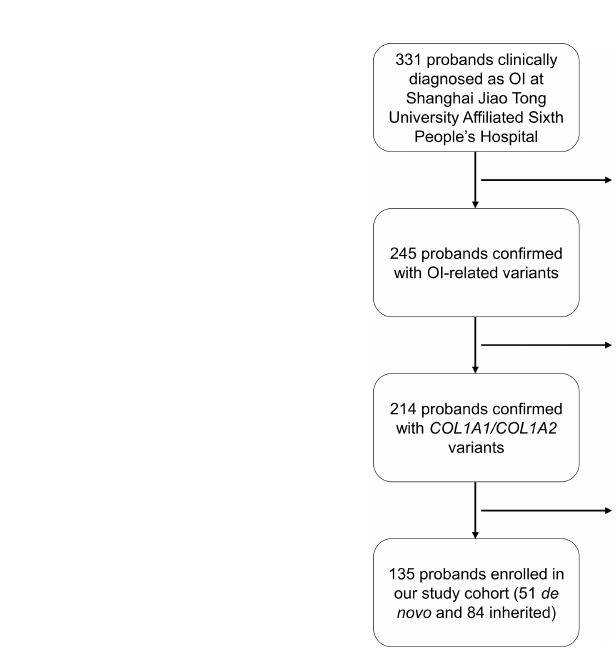
clinical phenotype.